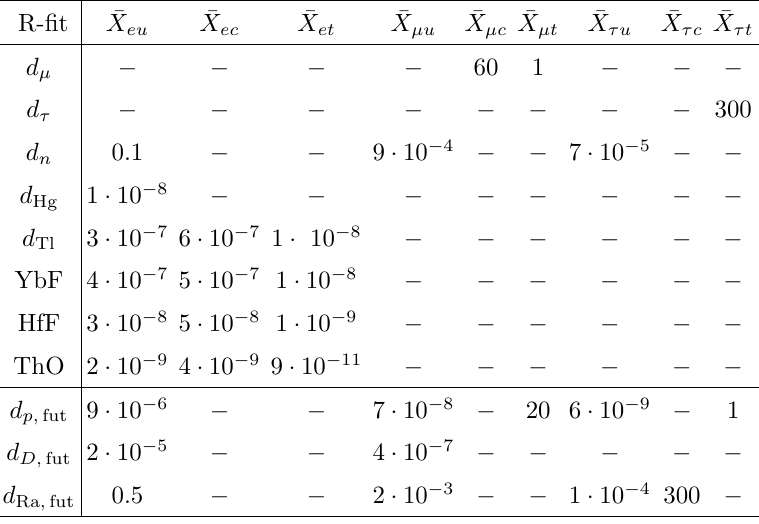
Table 7 . Limits on the R 2 couplings (cid:22) X lq (cid:17) m 2 took m LQ = 1 TeV and varied the matrix elements within their allowed ranges to get conservative